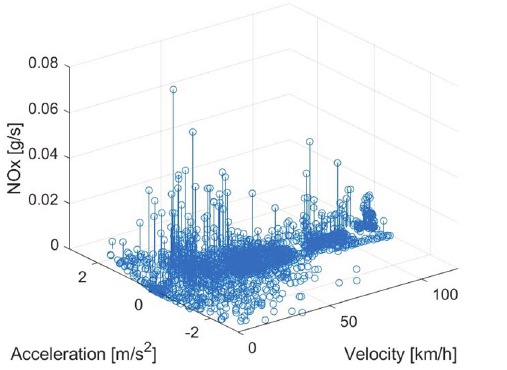
Fig, 11. Correlation between NO x emission intensity and velocity and acceleration of Euro 3 petrol fuelled vehicle